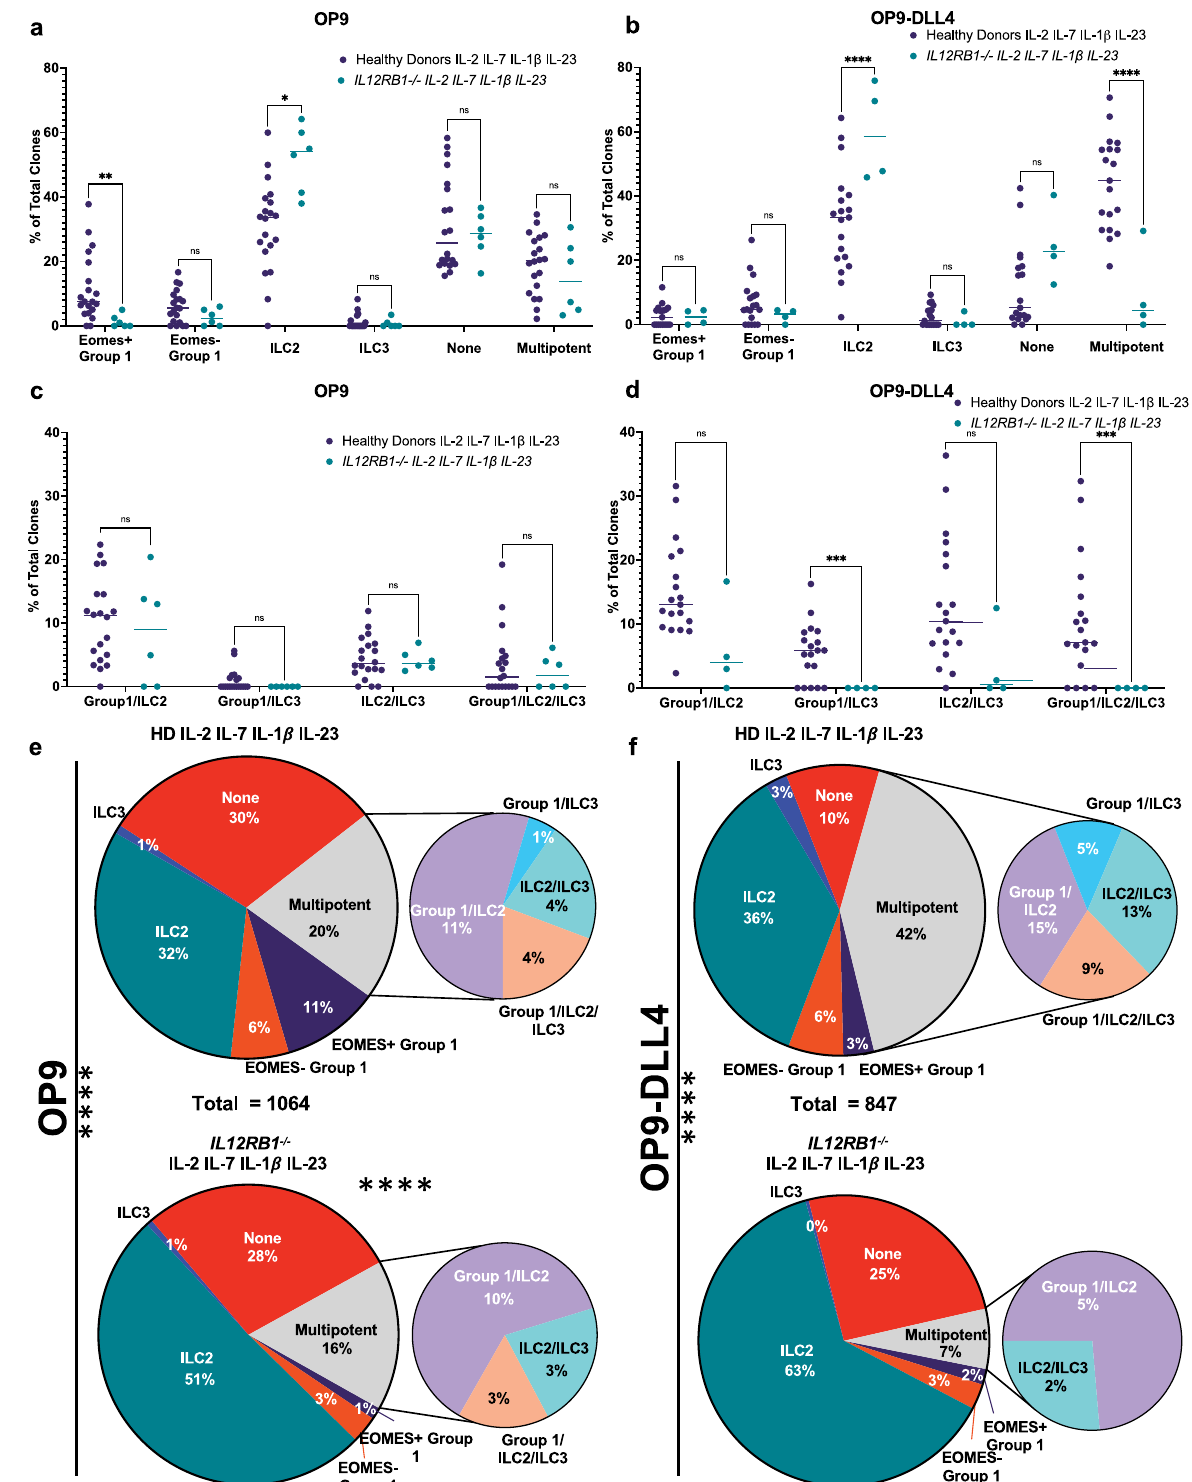
Fig.7|IL12RB1de fi ciencyresultsinreducedfrequencyofmultipotentandILC3 cytokine producing ILC clones. ILCP from healthy donors (purple circles) or IL12RB1 − / − patients (greencircles) werecloned on OP9(HD, n =20; IL12RB1 − / − , n =6) or OP9-DLL4 (HD, n =19; IL12RB1 − / − , n =4) stroma. Frequencies of unipotent (EOMES+ILC1, EOMES-ILC1, ILC2, ILC3, None) and total multipotent clones per individual healthy donor on a OP9 b or OP9-DLL4 stroma. Frequencies of types of multipotentcloneson c OP9 d orOP9-DLL4stroma.Datarepresentedasindividual matched values; each point corresponds to an individual donor. Overall